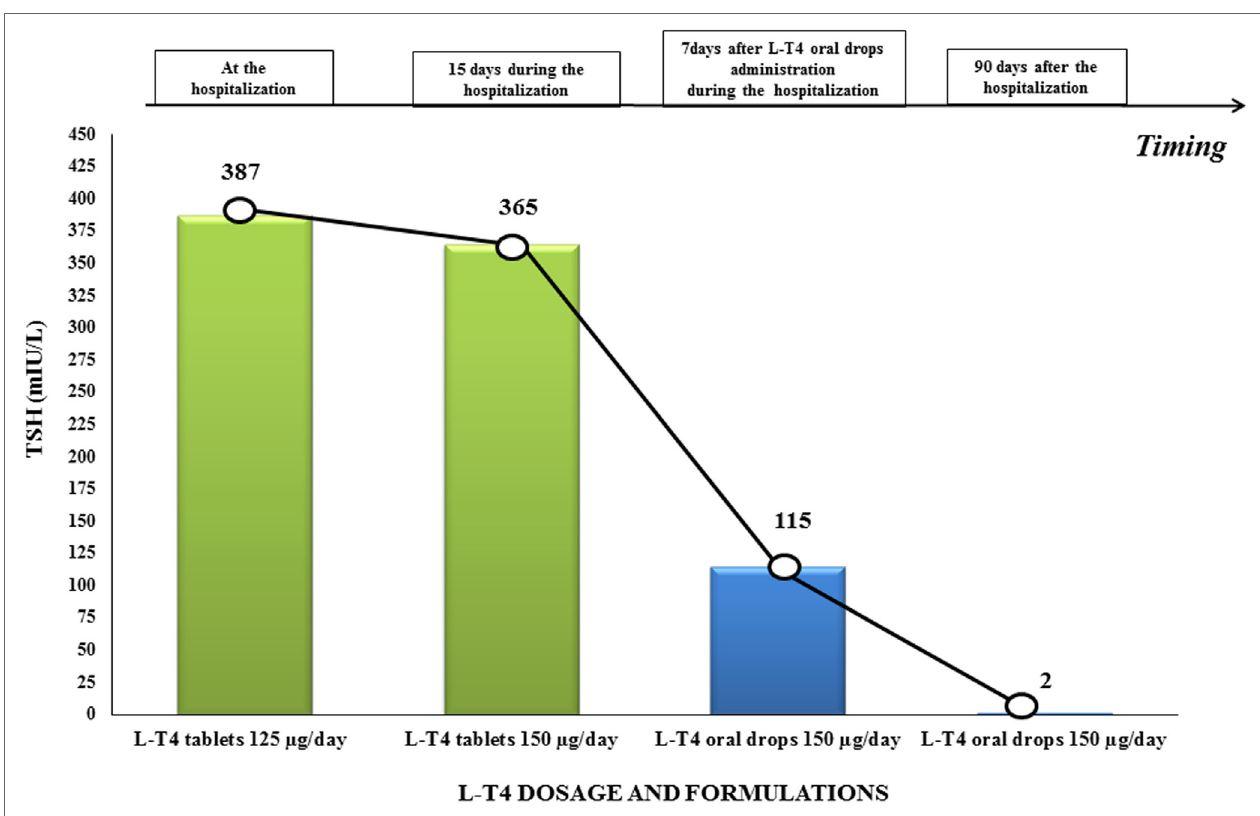
FIgURe 1 | TSH values before and after switching l -thyroxine ( l -T4) therapy from tablets to oral drops in our patient with systemic sclerosis-related malabsorption. TSH levels increased up to 387 μ U/ml. during l -T4 tablets. Oral drops were administered from day 4 and TSH values progressively normalized after 3 months.